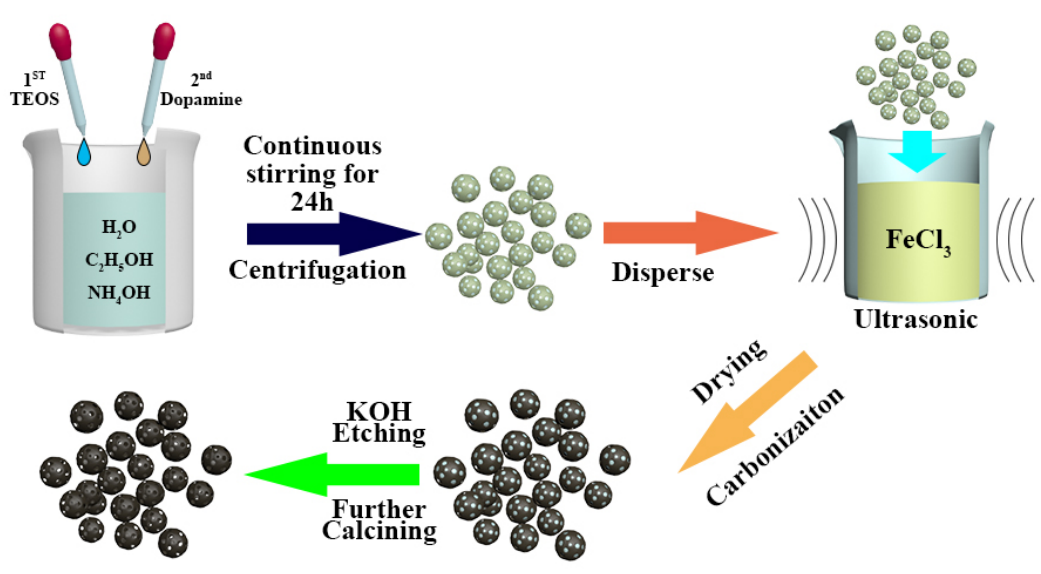
Figure 1. The synthesis route of Fe ions loaded in a hollow N-doped carbon nanosphere (Fe@HNCS)